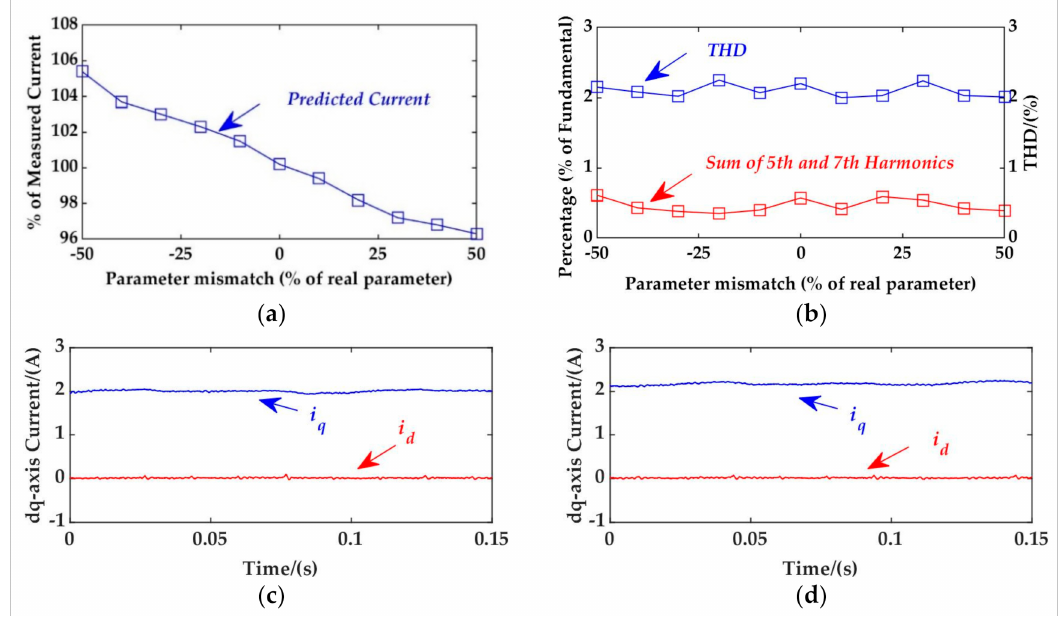
Figure 20. Test results under mismatched permanent magnet flux linkage. ( a ) Ratio of percentage of predicted current versus measured current. ( b ) THD, 5th and 7th harmonics of phase A current. ( c ) dq –axis currents under − 50% permanent magnet flux linkage error. ( d ) dq –axis currents under 50% permanent magnet flux linkage error.